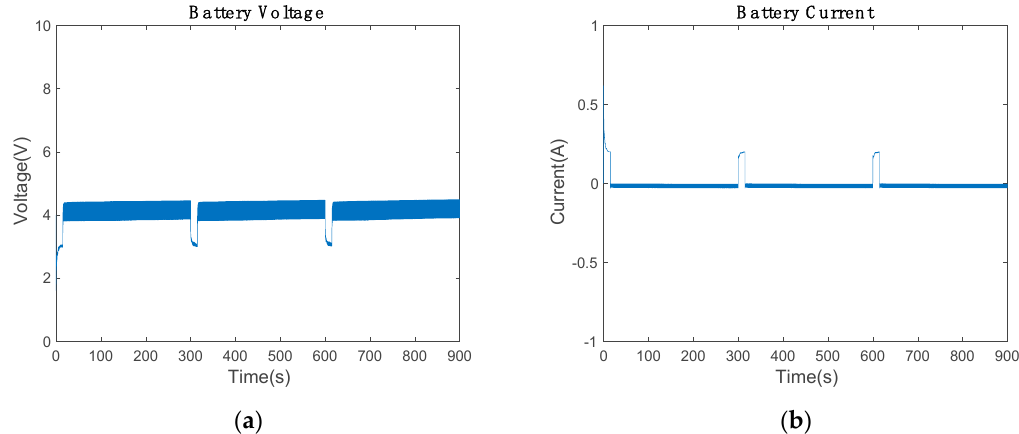
Figure 11. Battery state during the communication: ( a ) voltage and ( b ) current of the battery.